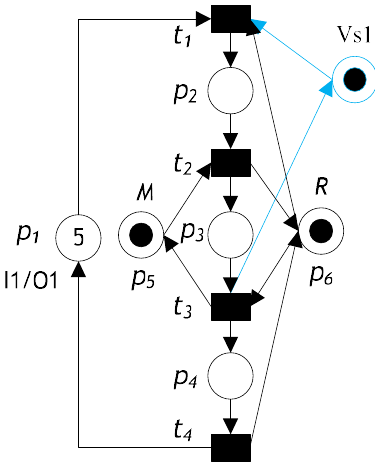
Figure 7. Controlled S 3 PR net by Algorithm 2.